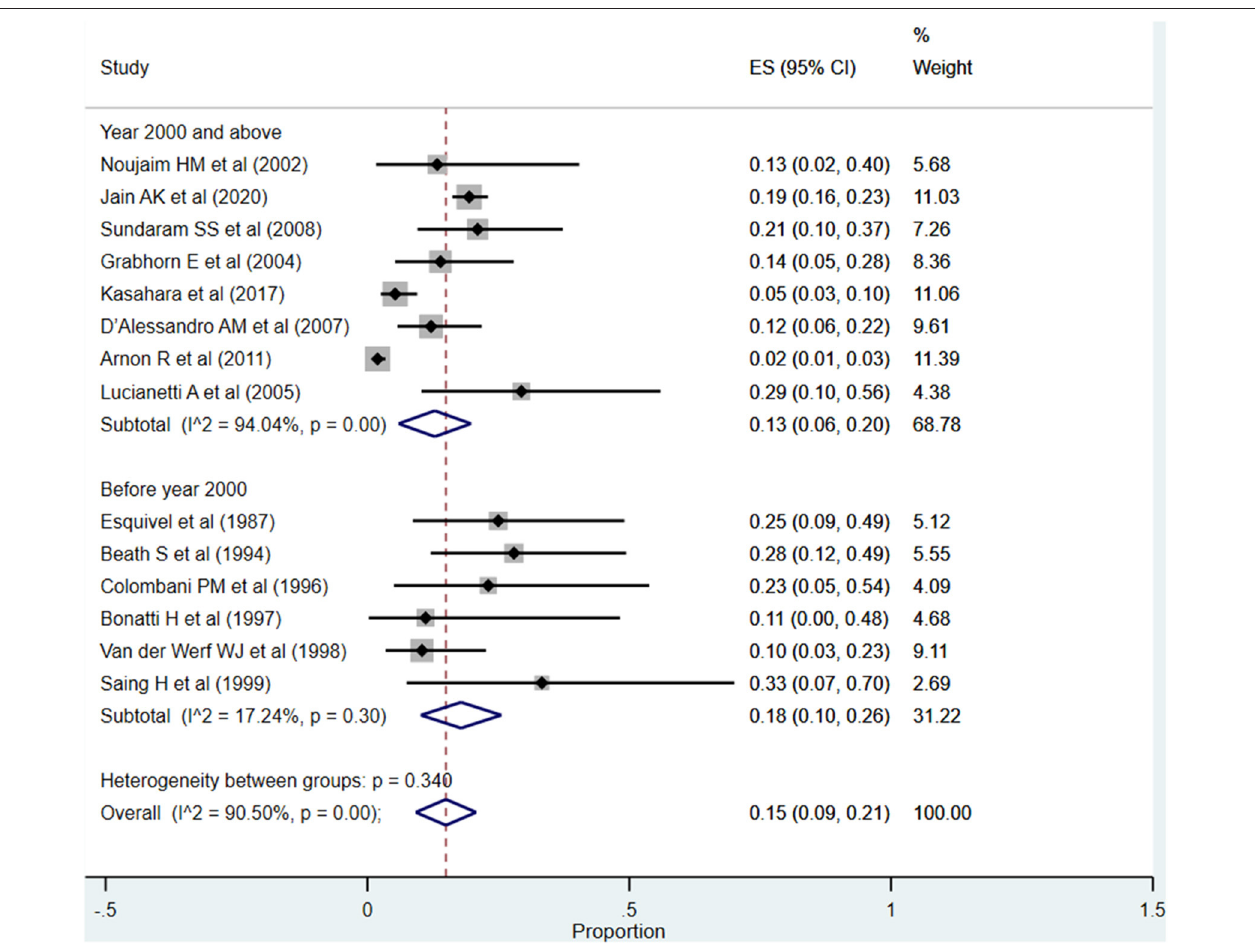
FIGURE 10 | Pooled rate for biliary complications in the included